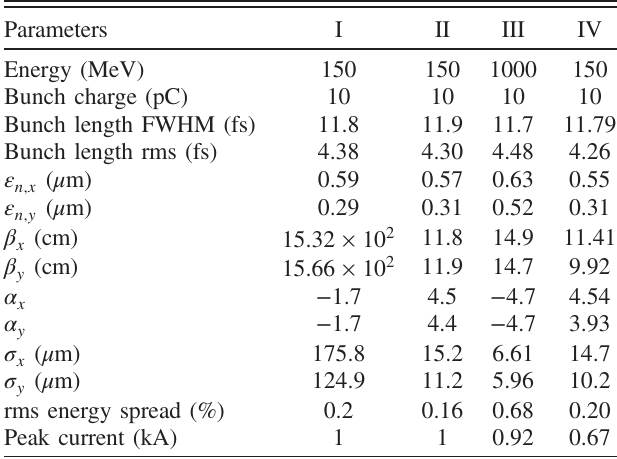
TABLE III. Bunch parameters at the BC exit (I), matched beam at the entrance of plasma cell (II), accelerated beam after the plasma cell (III) and the matched beam at the plasma without including the effects of SC (IV). The same quadrupole settings are used for II and